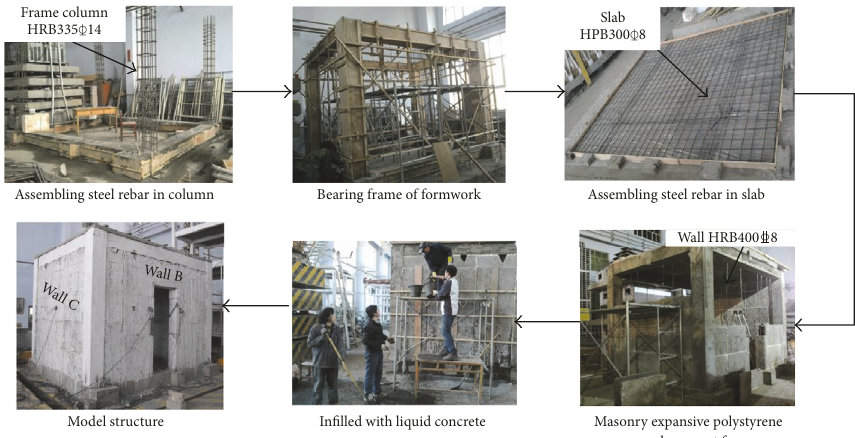
Figure 5: Construction process of the model structure.